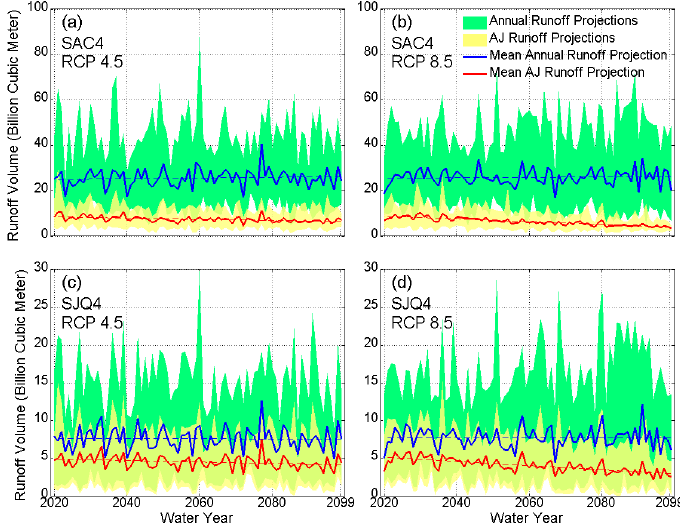
Figure 7. Projected April–July and annual runoff for Sacramento Four Rivers (SAC4; a , b ) and San Joaquin Four Rivers (SJQ4; c , d ) under RCP 4.5 and RCP 8.5 scenarios throughout the projection period (2020–2099). Dash lines designate trend lines. Note that the Y -axis scales for SAC4 and SJQ4 are different. Table 4. Trend slope and corresponding p -values for mean projections on April–July and annual runo ff . April–July Runo ff Scenario